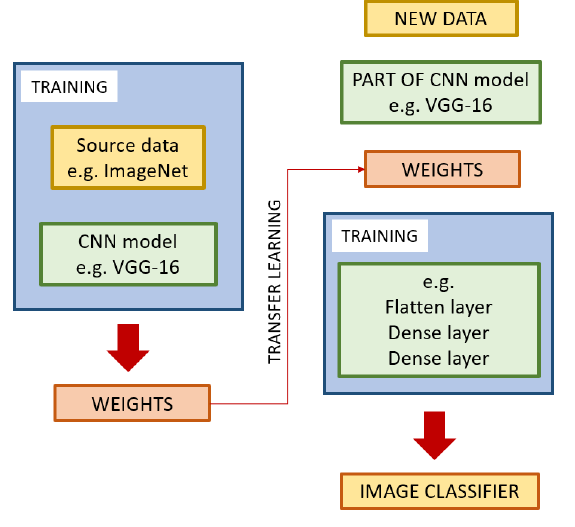
Figure 2 . Network architecture example.